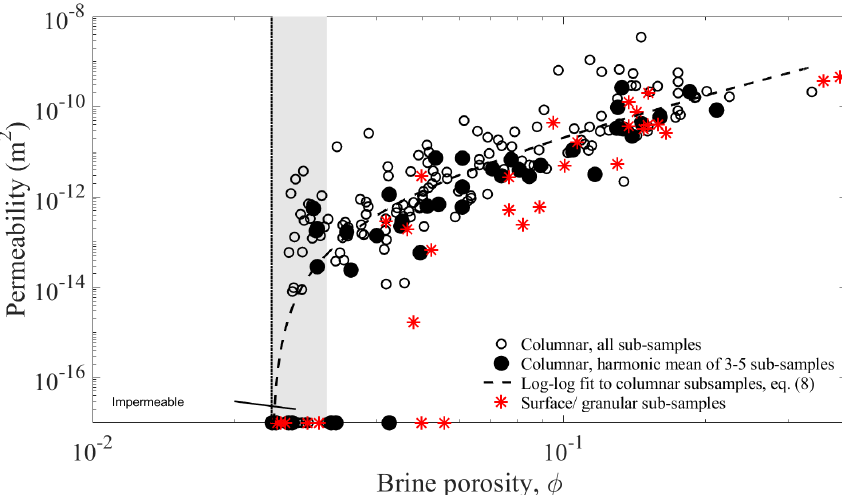
Figure 13. Comparison of simulated vertical permeability K and φ − φ c for columnar samples (as shown in Fig. 7 and here as open circles) to two other simulation results. The solid circles are harmonic means of all sub-samples (normally four to five) from each basic sample cut in the field (and centrifuged). The red stars are permeability results for near-surface samples (up to 5cm from the surface) that were classified as granular ice and thus excluded from the basic